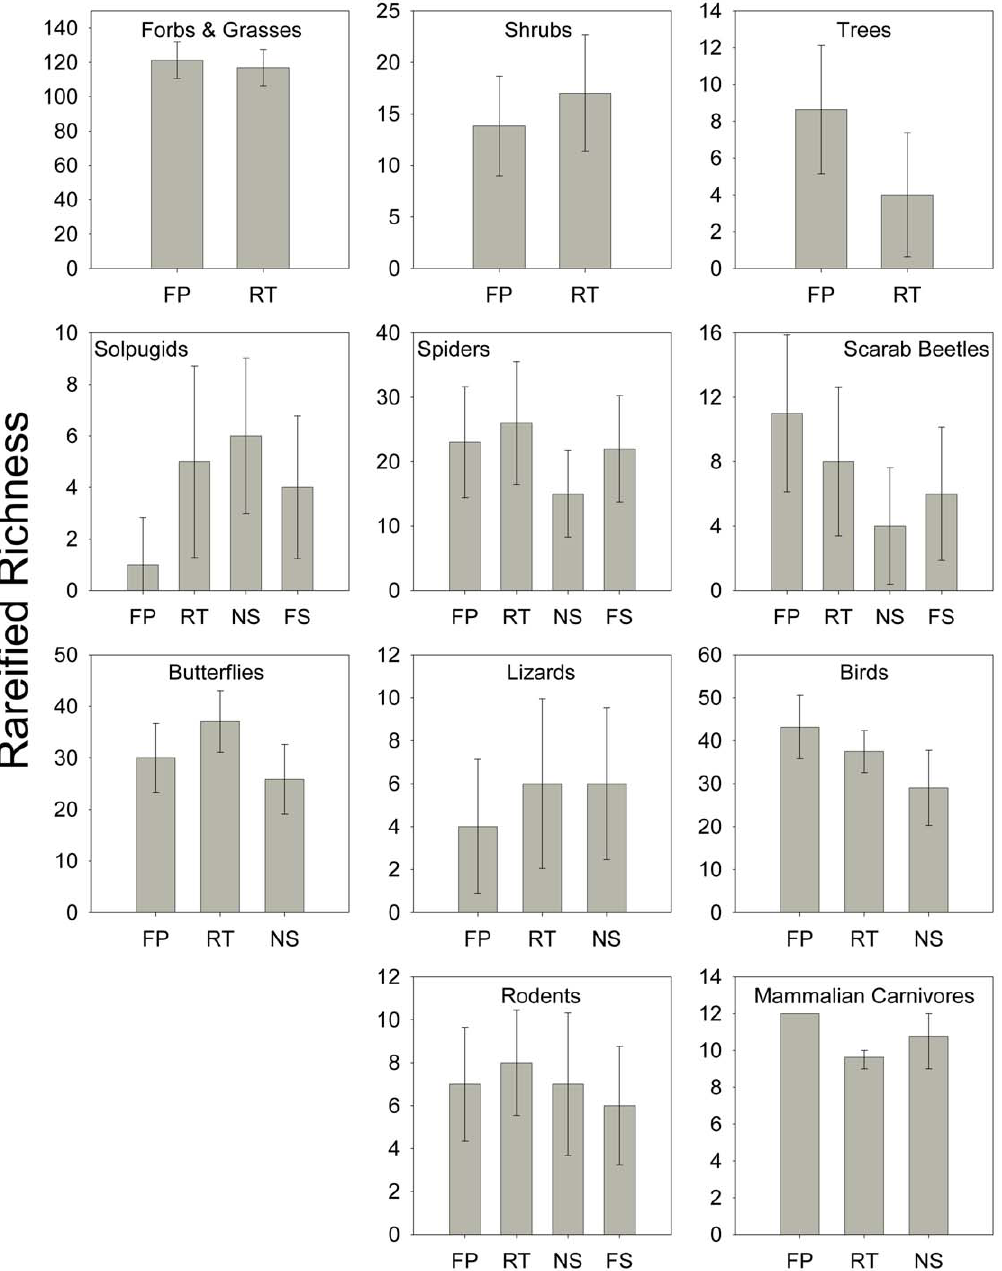
Figure 3. Richness by habitat type for each taxonomic group. Mau Tau rarefied richness values ( 6 95% confidence intervals) in four different habitat types for the eleven taxa sampled along the upper San Pedro River (abbreviations as in Table 1). The only values that had non-overlapping 95% confidence intervals were solpugids in NS and FP habitat types.